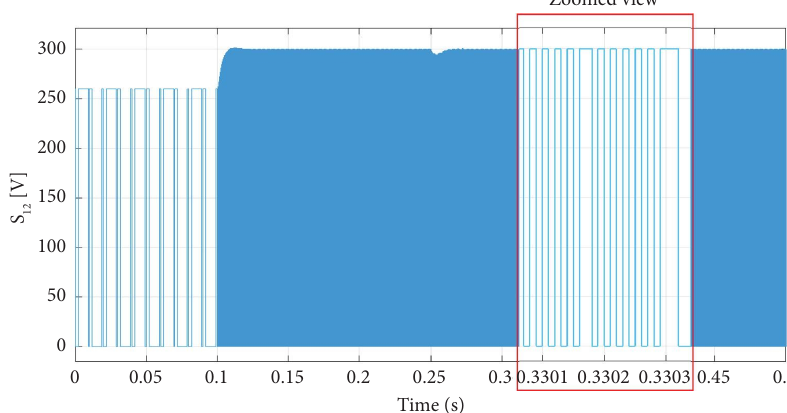
Figure 17: Te voltage output of SAPF.